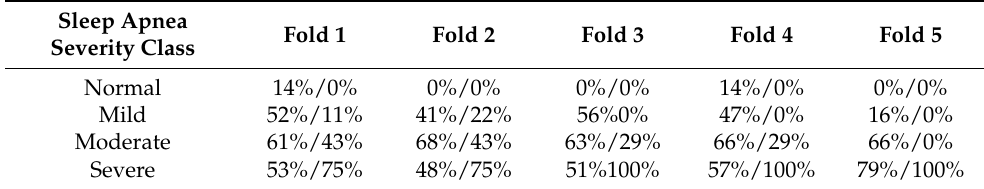
Table 4. Apnea severity estimation accuracy of each instance of the model. Values represent true positives for each class in SHHS-1/PhysioNet databases.